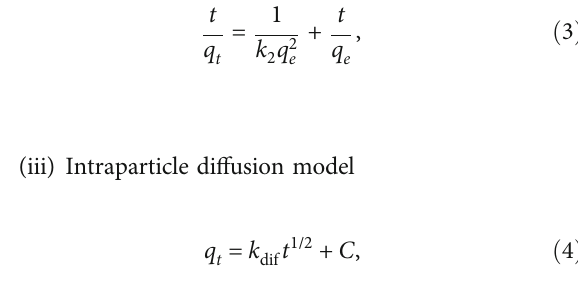
Figure 6: E ff ect of pH on adsorption behavior of MB by CTAB free MSNs, Asp-MSNs, and Gly-MSNs ( C